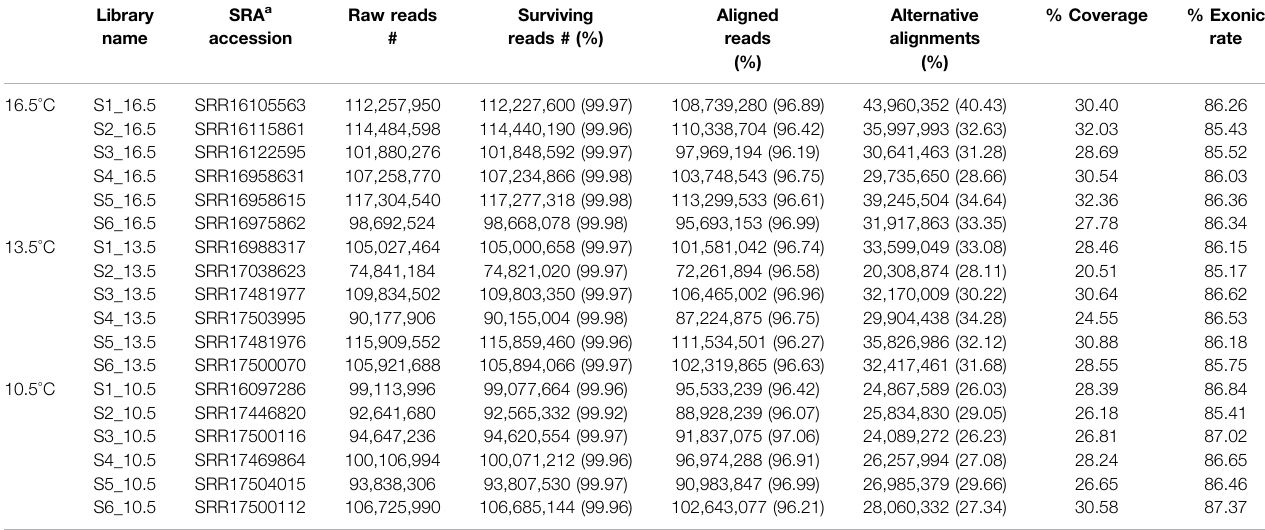
TABLE 1 | Trimming and alignment metrics of each biological replicate RNA-seq library. Library